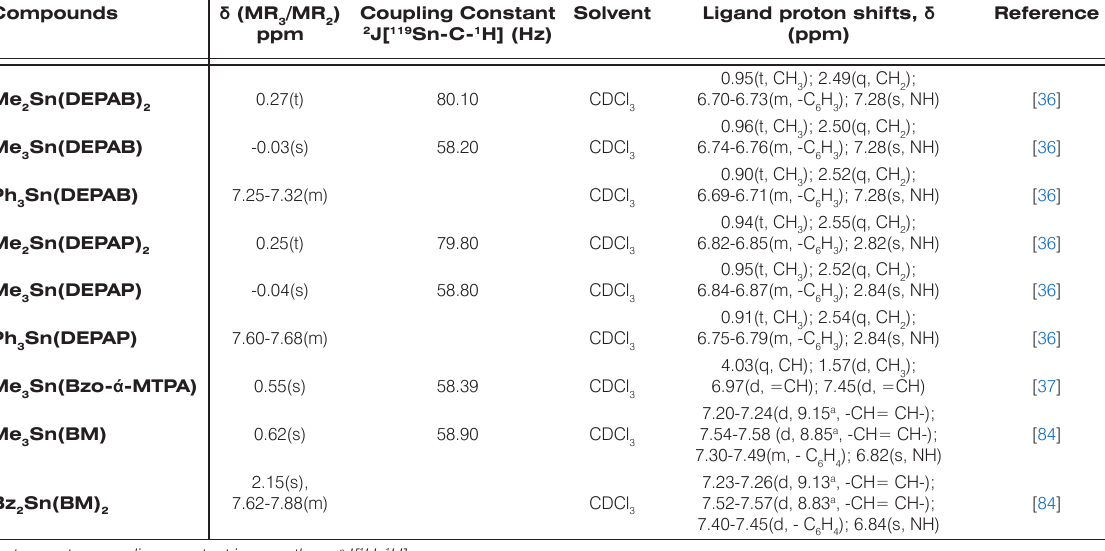
Table 1. 1 H NMR data of R Compounds δ (MR